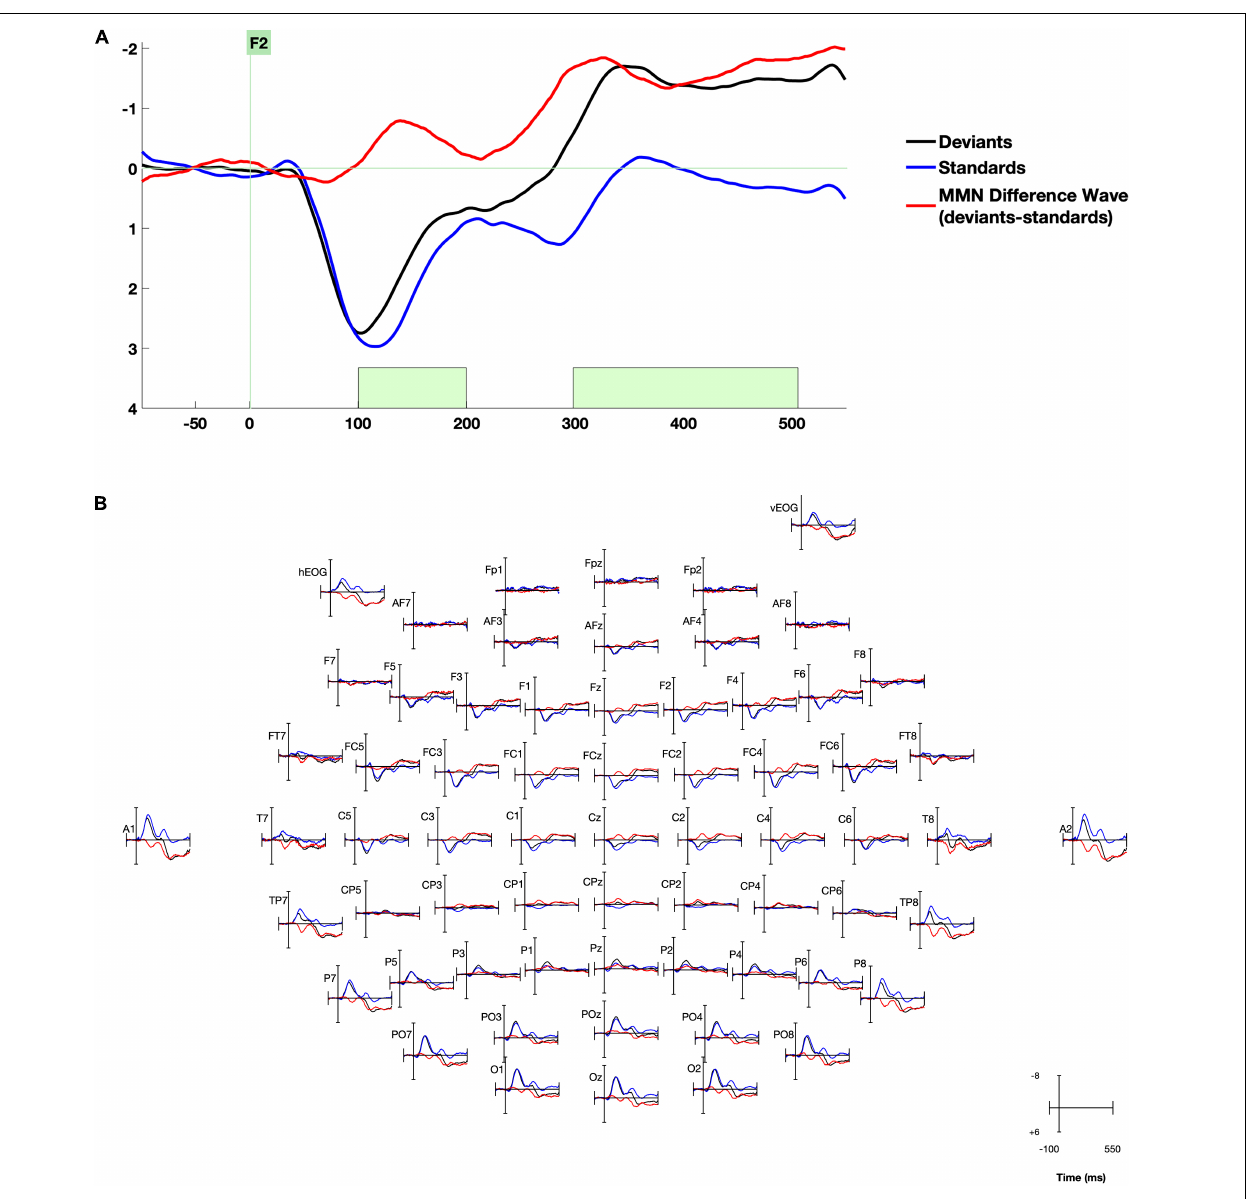
FIGURE 1 | Whole-group grand average waveforms. (A) Data are presented at right frontal electrode site F2. Time windows selected for analysis are highlighted in green. (B) Data from all electrodes processed. Negative is plotted